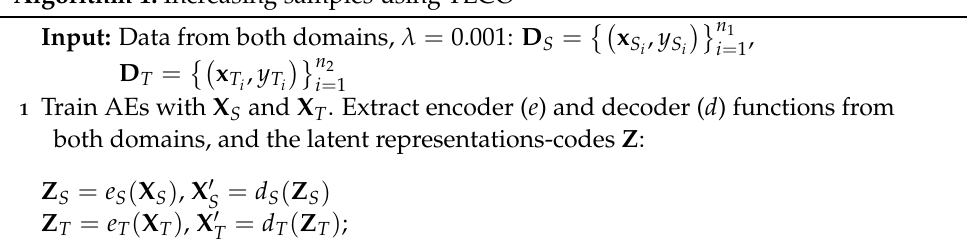
Figure 5. Scheme of proposed method for transfer of samples between domains and the support of a learning task in the target domain using TLCO. Algorithm 1: Increasing samples using